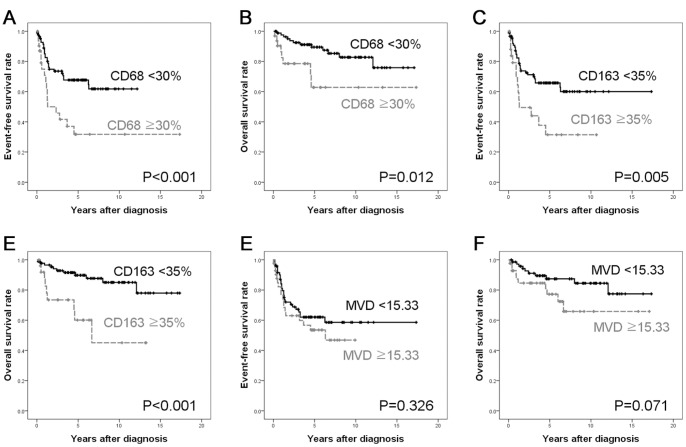
Comparison of survival rates according to CD68, CD163, VEGF expression and MVD.Event-free survival (EFS) (A) or overall survival (OS) (B) was significantly worse in high-CD68 group. EFS (C) or OS (D) was significantly worse in high-CD163 group. MVD was not significantly associated with EFS (E). Patients with high MVD had worse OS (F) than those with low MVD, although the statistical significance was not reached.